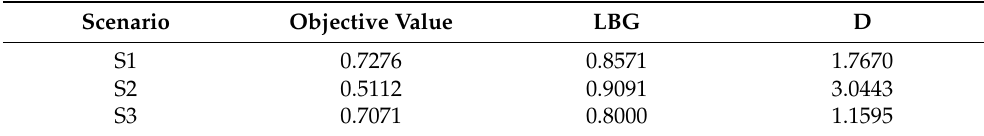
Table 2. Computational results for S1, S2 and